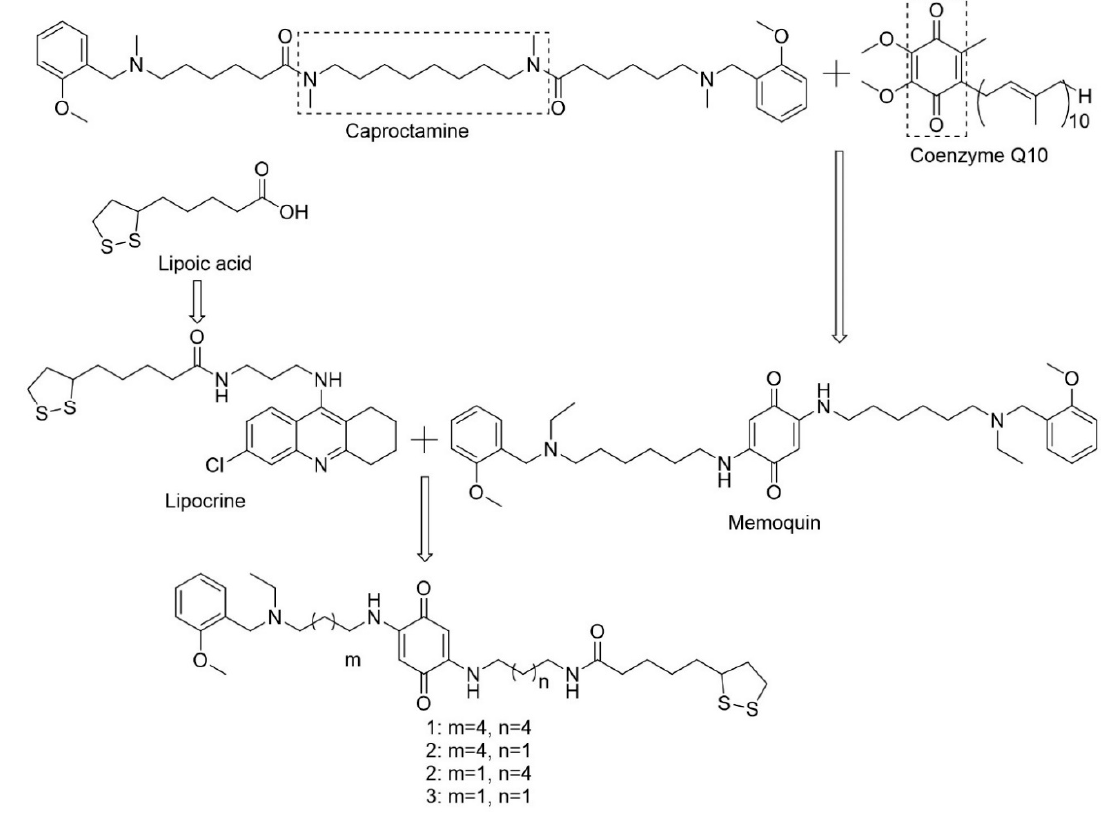
Figure 9. Design of memoquin through the conjugation of caproctamine and CoQ10, and design of lipoic acid memoquin derivatives through the conjugation of memoquin and lipocrine. Adapted from [104,105] .